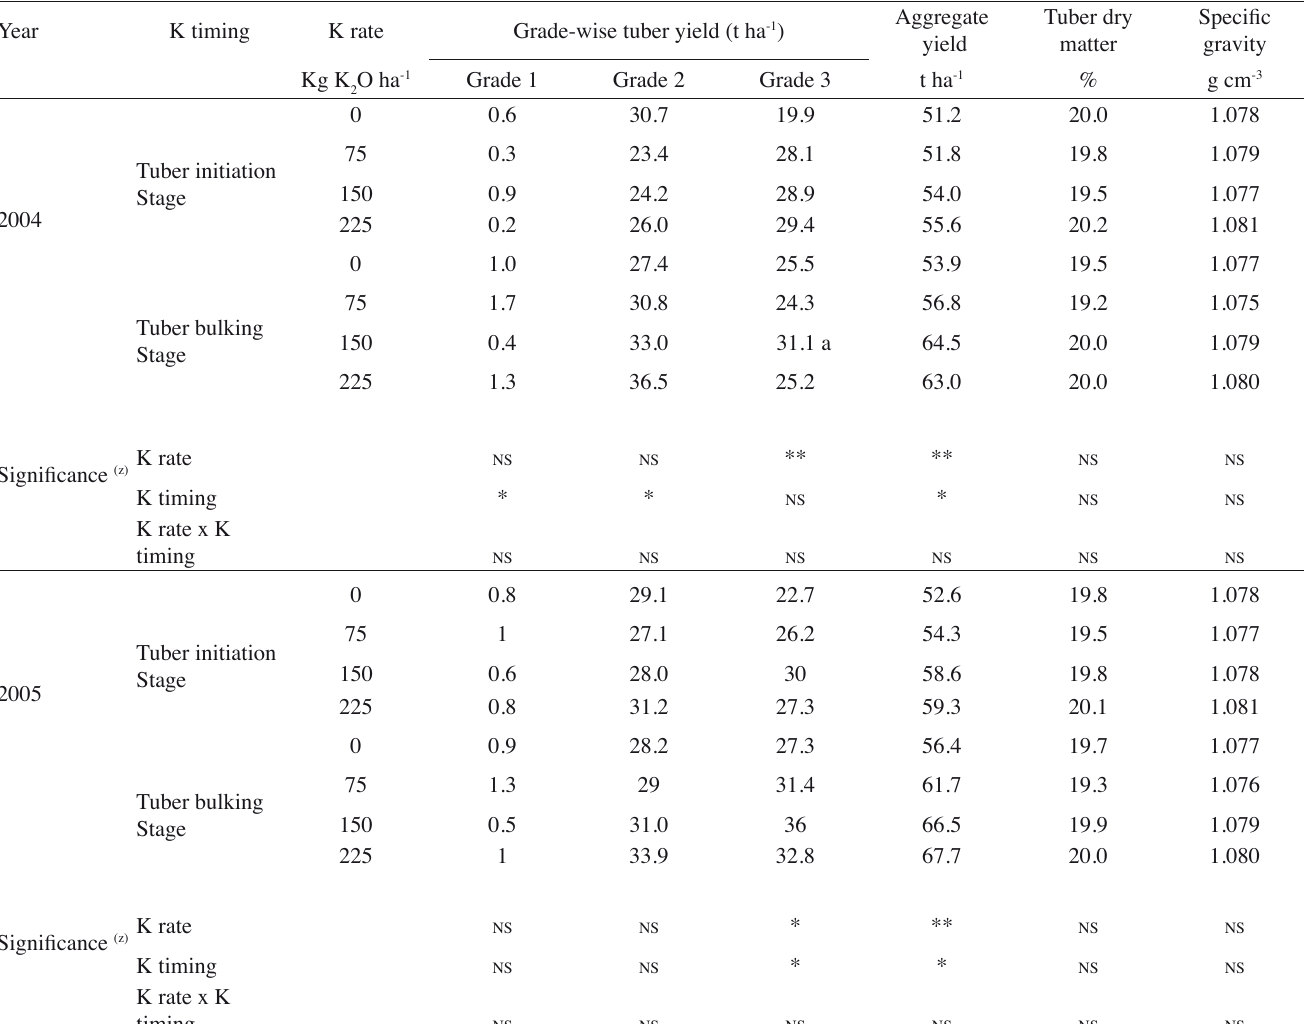
Table 1 - Effects of potassium application rates and K application timing on grade-wise and aggregate tuber yield, tuber dry matter and specific gravity of potato plants grown in 2004 and 2005